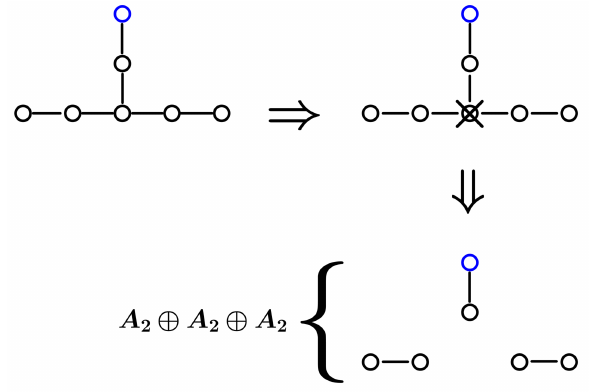
subalgebra in the N = 4 , 8 case. Figure 9 . A ⊕ 3 2